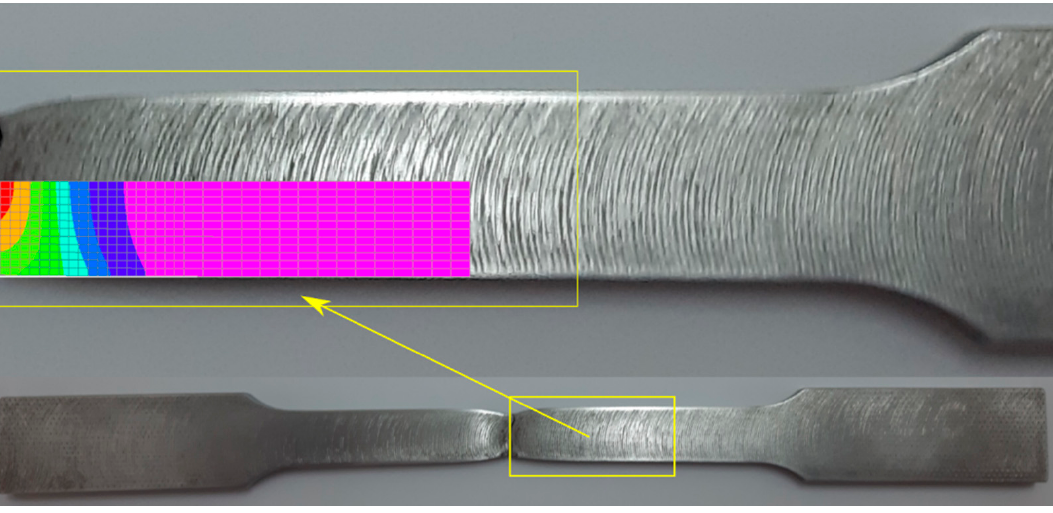
Figure 12. S355J2+N steel specimen with the equivalent plastic strain field at the critical zone after the experiment.